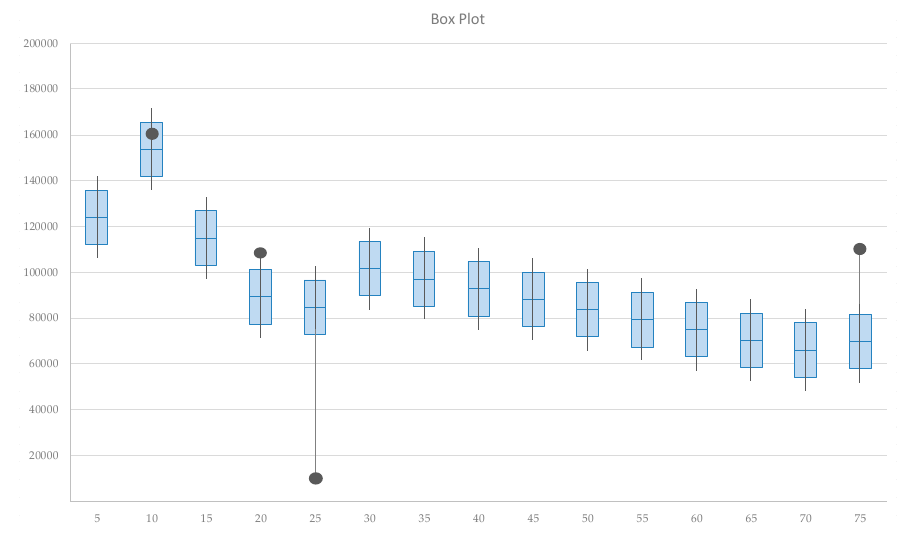
Figure 6. Box plot of nutrient export simulated values.